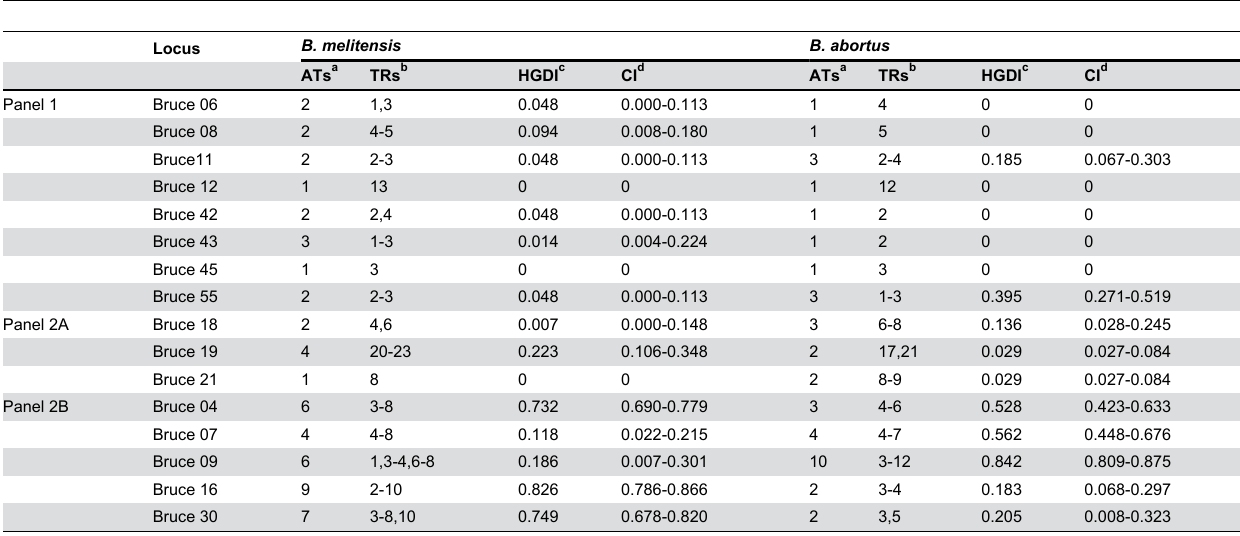
Table 1. Allelic types and Hunter and Gaston Diversity index (HGDI) of B. melitensis and B. abortus isolates for 16 loci in this